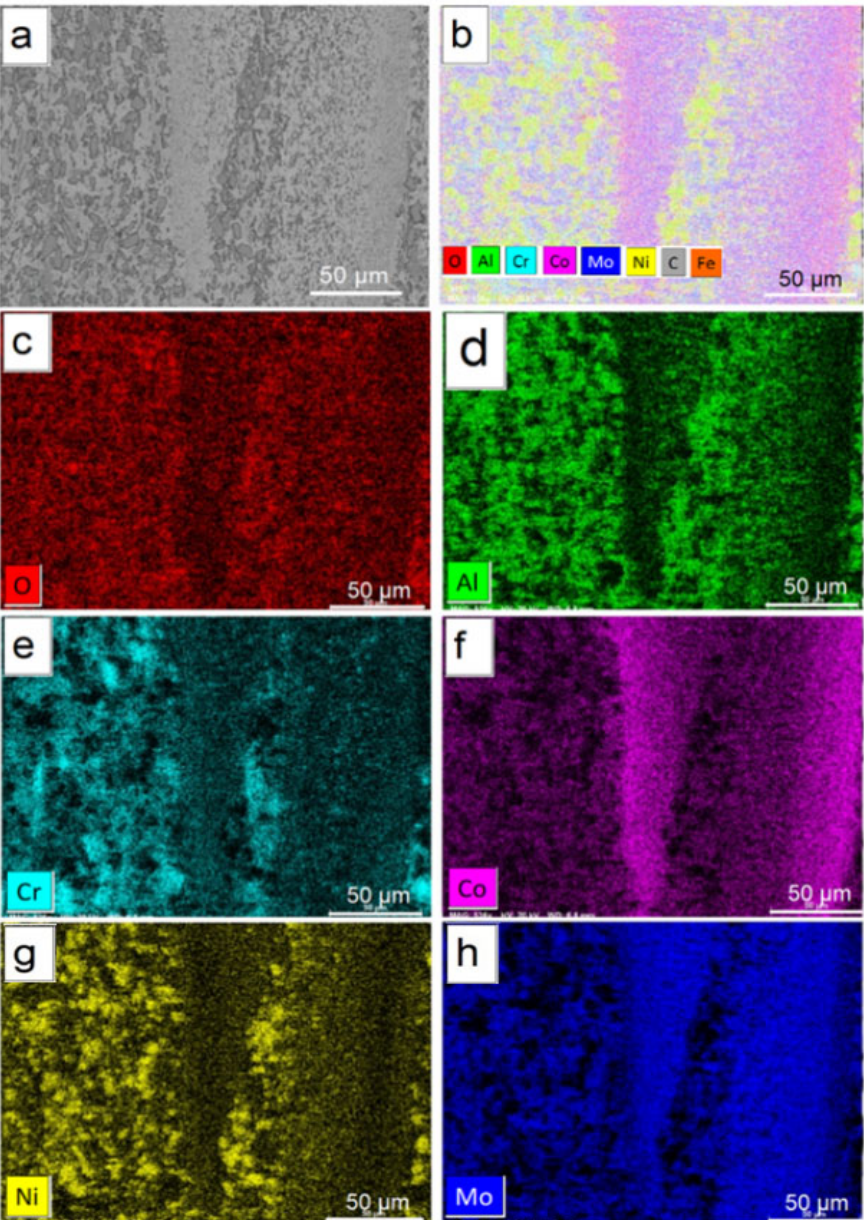
Figure 11. Microstructure and elements’ distribution maps in the wedge-shaped region: ( a ) microstructure, ( b ) all elements, ( c ) O, ( d ) Al, ( e ) Cr, ( f ) Co, ( g ) Ni, ( h ) Mo . Figure 12 shows an area with an increased content of the Co–Mo phase. Oxidized areas with high chromium content were clearly visible. There was an obvious area that